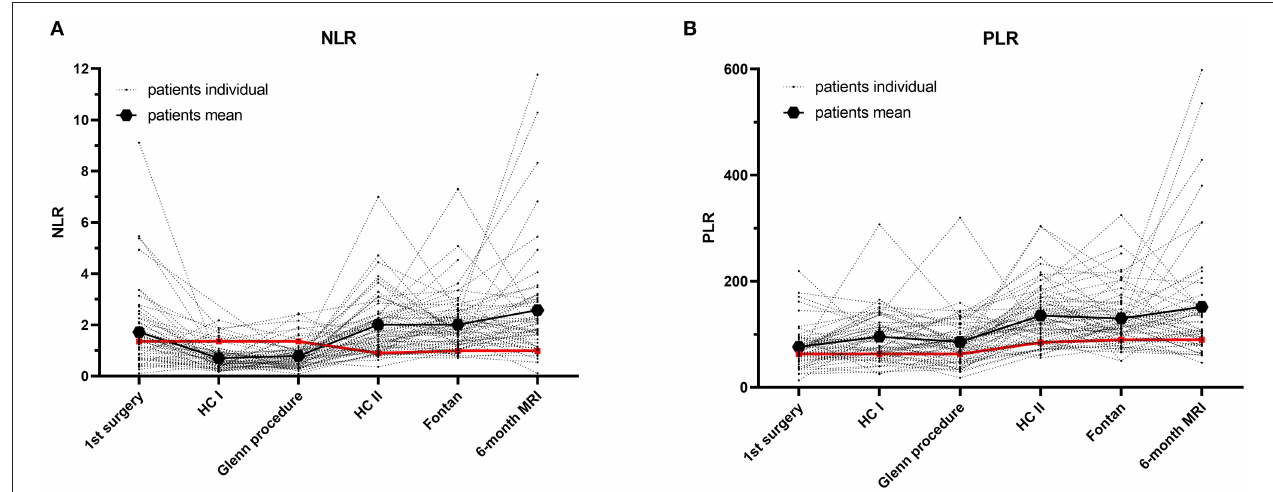
FIGURE 2 | Individual courses of neutrophil-to-lymphocyte ratio (NLR) and platelet-to-lymphocyte ratio (PLR) of univentricular patients undergoing Fontan pathway. (A) NLR. (B) PLR. Mean of control group is illustrated in red. Mean values of all Fontan patients are given in thick black.